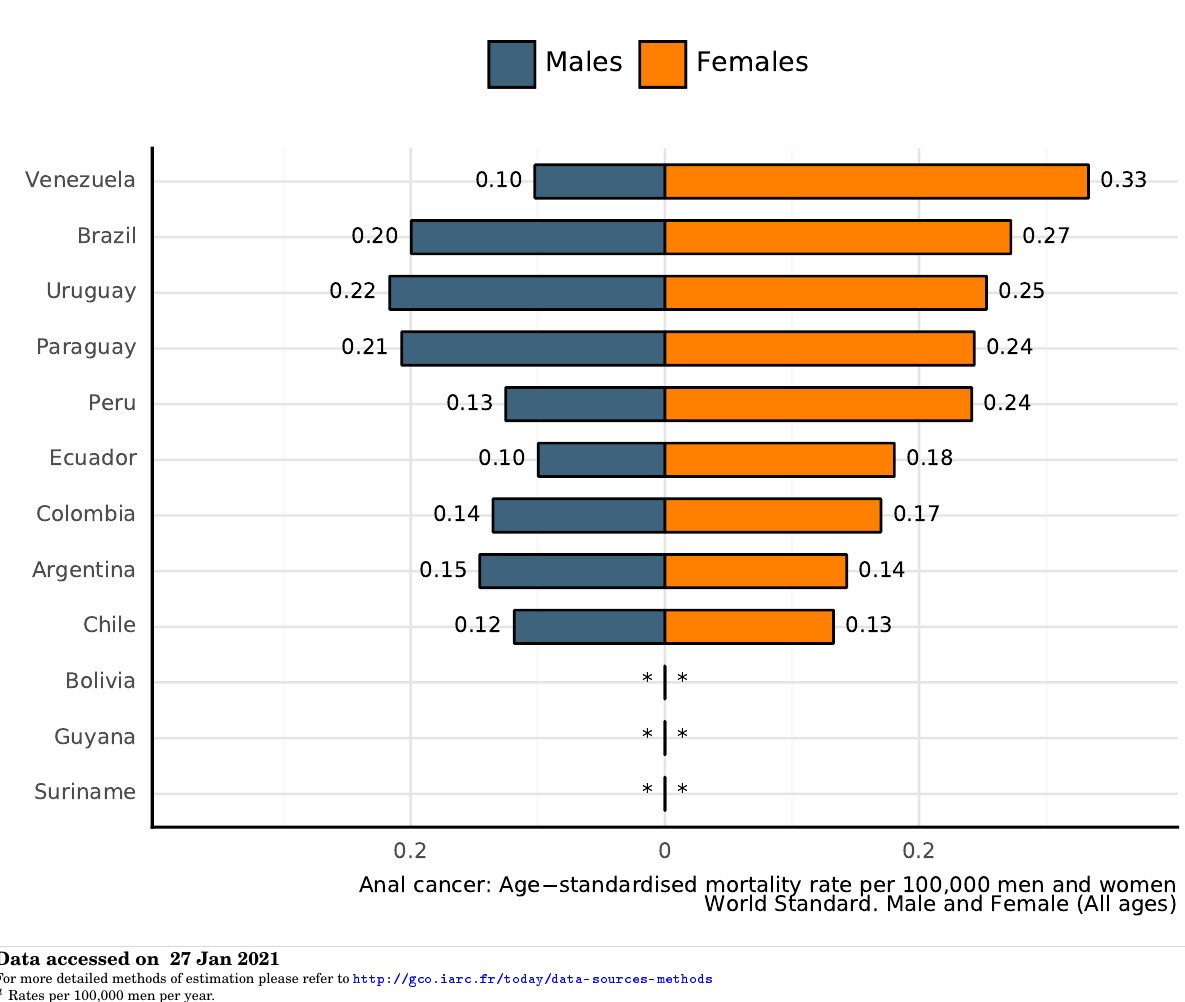
Figure 108: Age-standardised mortality rates of anal cancer of Peru (estimates for 2020)